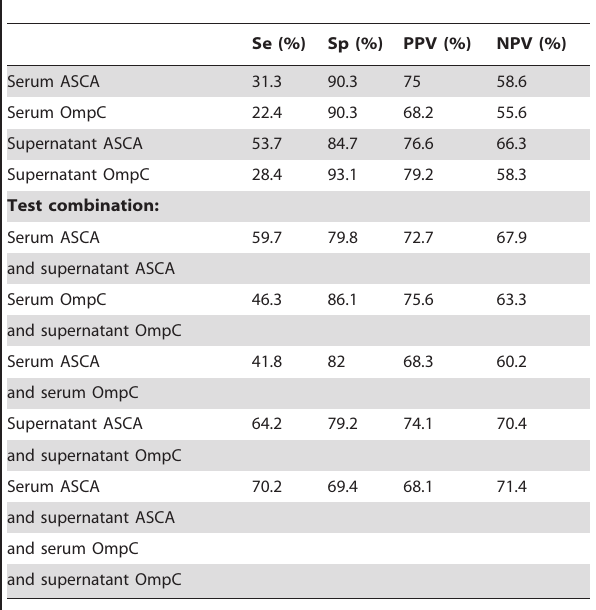
ASCA: Anti- Saccharomyces cerevisiae antibodies, anti-OmpC: anti-outer membrane porine C antibodies, Se: sensitivity, Sp: specificity, PPV: